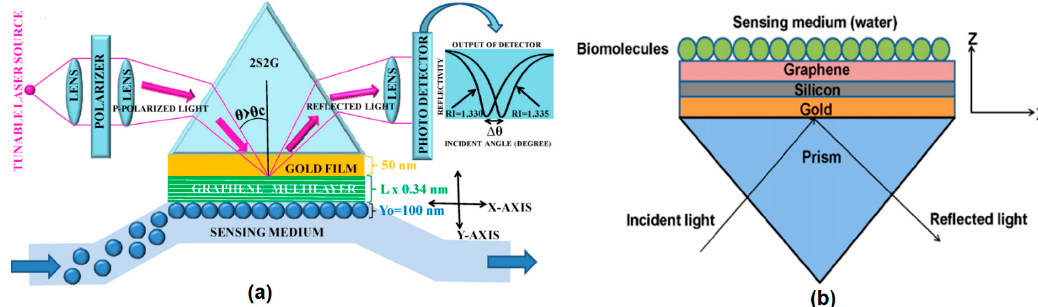
Figure 4. The SPR structure investigated by ( a ) Maharana et al. (left) and ( b ) Verma et al. (right) (adapted with permission from Reference [33,34], copyright Elsevier).